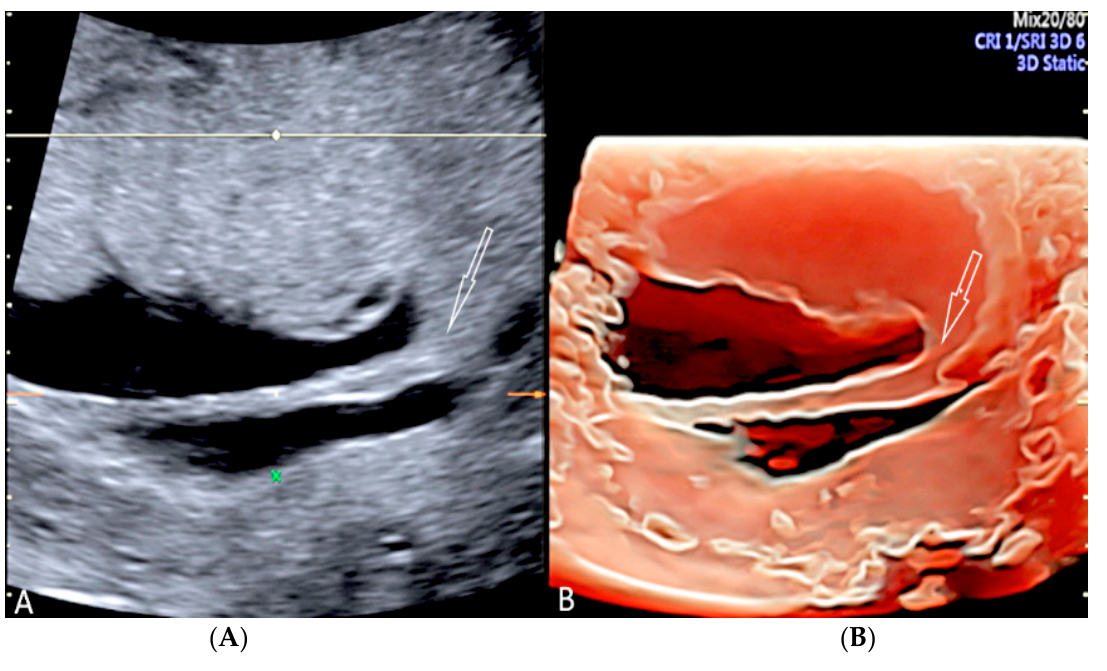
Figure 8. Circumvallate placenta with anterior placenta at two-dimensional ultrasound ( A ). Three- dimensional ultrasound using HD-Live Silhouette™ mode ( B ) at 20 week’s gestation shows the raised edge of the placenta as a linear band of tissue that may mimic a uterine synaechia (arrows).